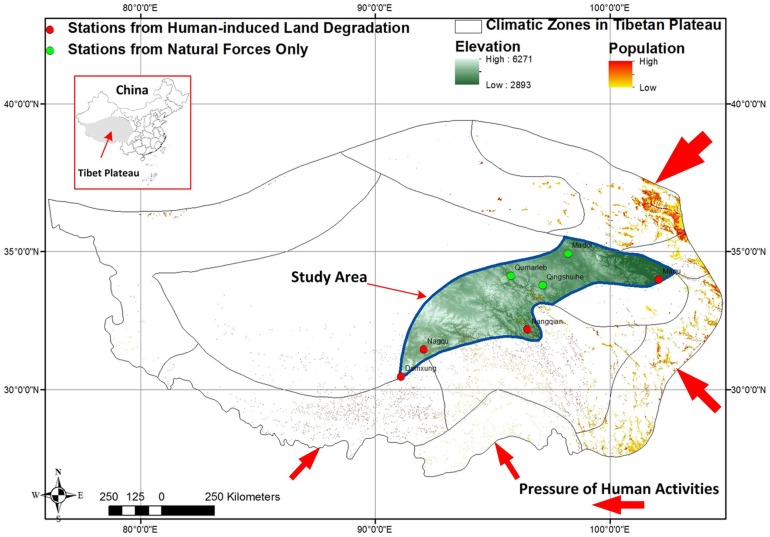
Study area.The study area is located in the central Tibet Plateau, with 7 stations in the same climatic zone. Distribution of population is a reasonable indicator for pressures from human activities. Stations in areas of human-induced land degradation (Group B including Damxung, Maqu, Nangqian and Nagqu) are close to high-pressure areas, while stations in areas of natural forces only (Group A including Qumarleb, Madoi and Qingshuihe) are located in the sparsely populated hinterland.